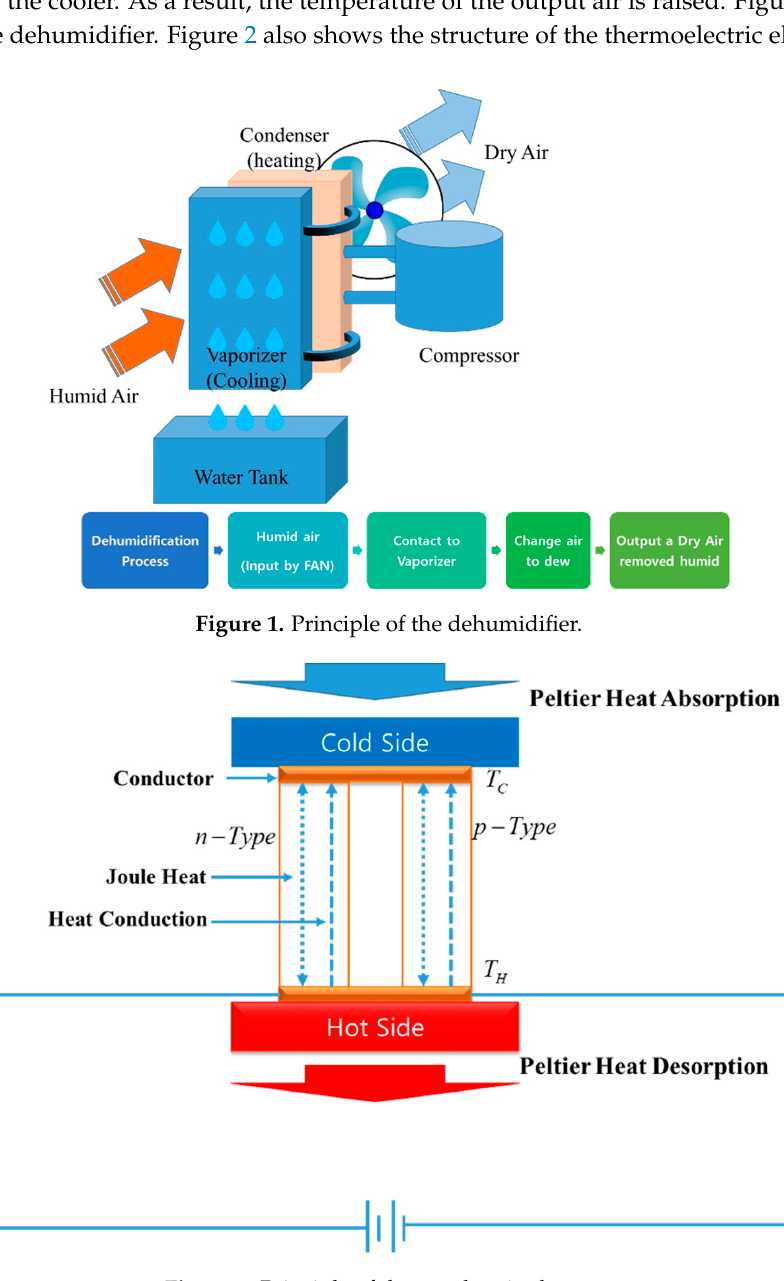
Figure 2. Principle of thermoelectric element.